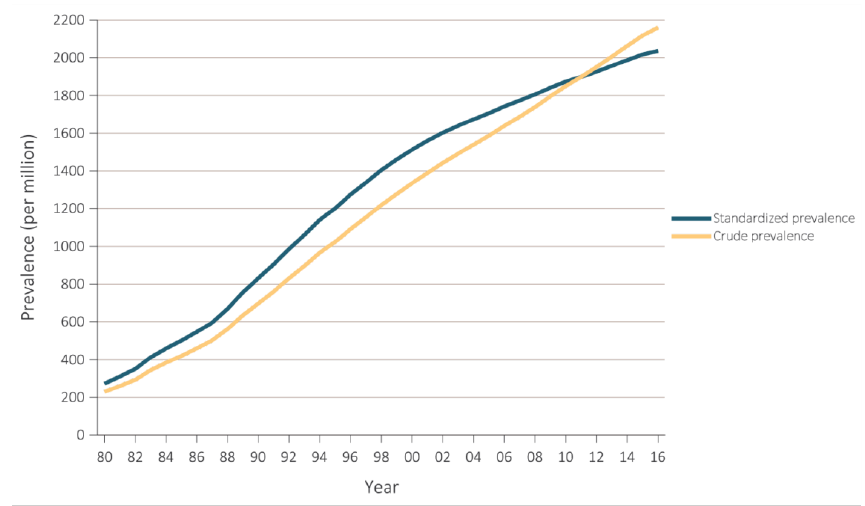
Figure 1. Prevalence of end-stage kidney disease (ESKD) in the United States (US) population, 1980 – 2016. This figure shows a steady increase in ESKD prevalence over recent ~35 years in the US. Standardized for age, sex, and race. Data Source: USRDS 2018 Annual Data Report [4].